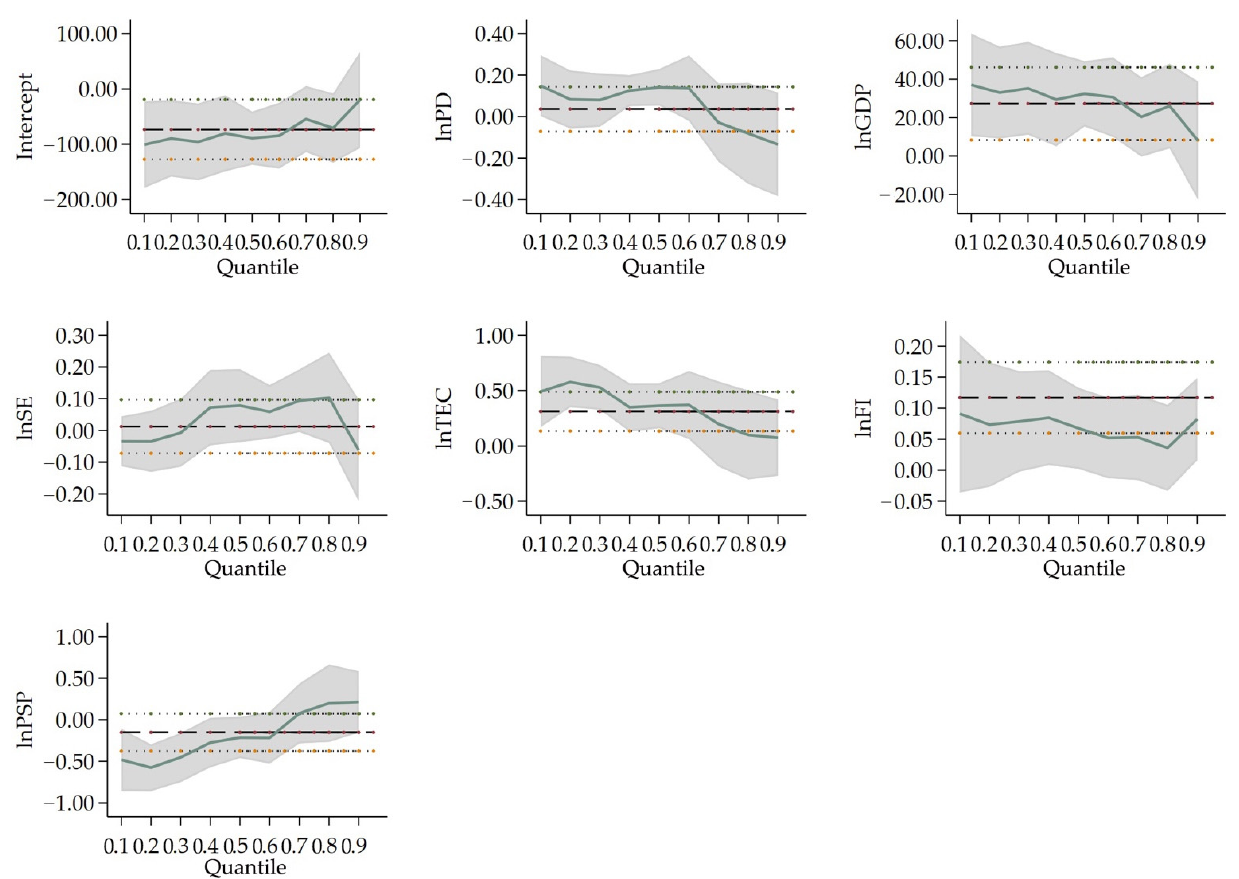
Figure 2. Change in variables’ coefficients in Type I cities’ quantile regression. Notes: The thicker dashed lines indicate the OLS regression estimates for the independent variables; the area which is parallel with thinner dashed lines is the confidence interval (95% confidence level) for the regression coefficients; The solid lines are the quantile regression coefficients of the respective variables, and the shaded area is the confidence interval (95% confidence level) of the quantile regression analysis estimates. The horizontal axis is the quantile of the dependent variable; the vertical axis is the regression estimate of the independent variable.